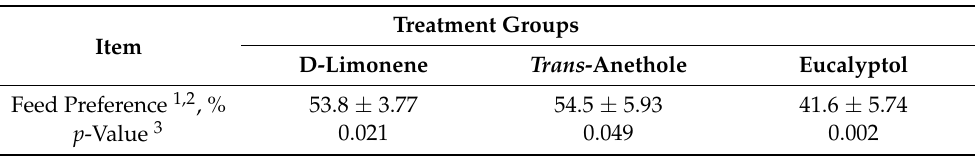
Table 3. Feed preference percentage of weaned piglets (d 8 to d 14) for tested BCs versus unsupple- mented reference diets by using a double-choice feeding test.